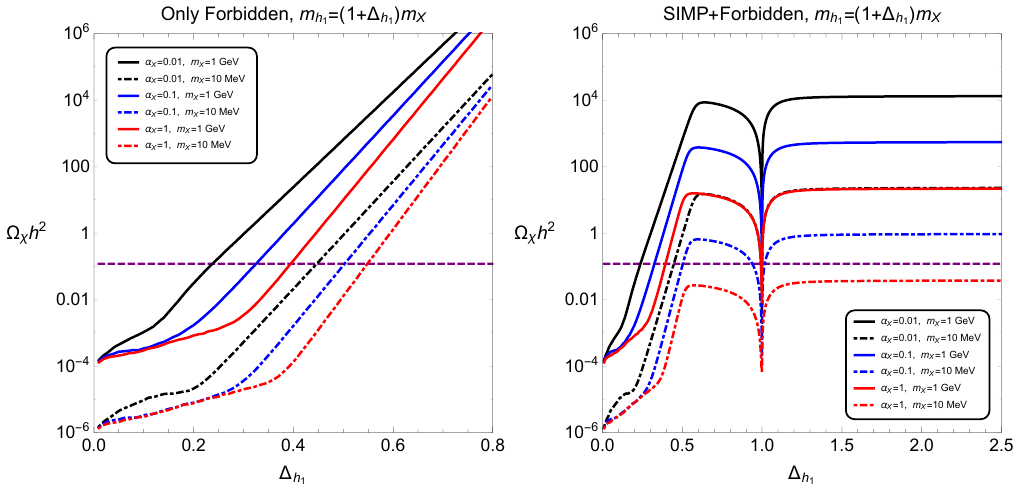
= ( m h (cid:0) m X ) =m X , for forbidden 1 1